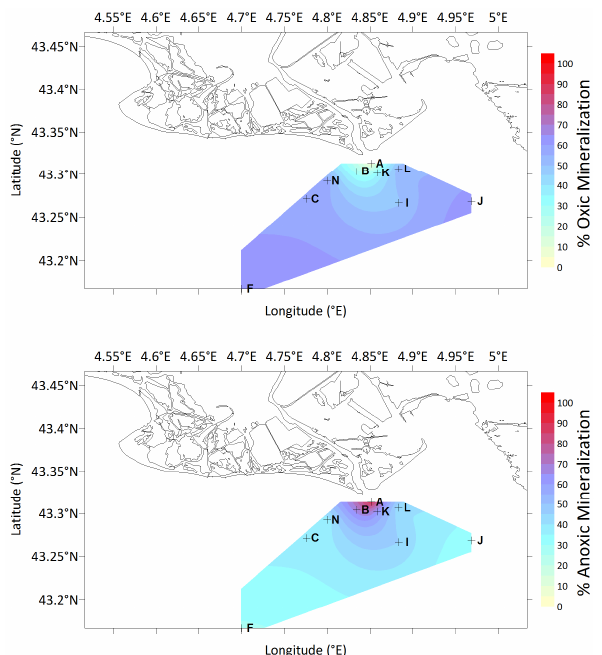
Fig. 5. Relative contribution of principal organic carbon mineral- ization pathways (oxic mineralization and anoxic mineralization) on total organic carbon mineralization expressed in % in the Rhˆone River prodelta and its adjacent continental shelf. Denitrification process accounted for less than 6%.